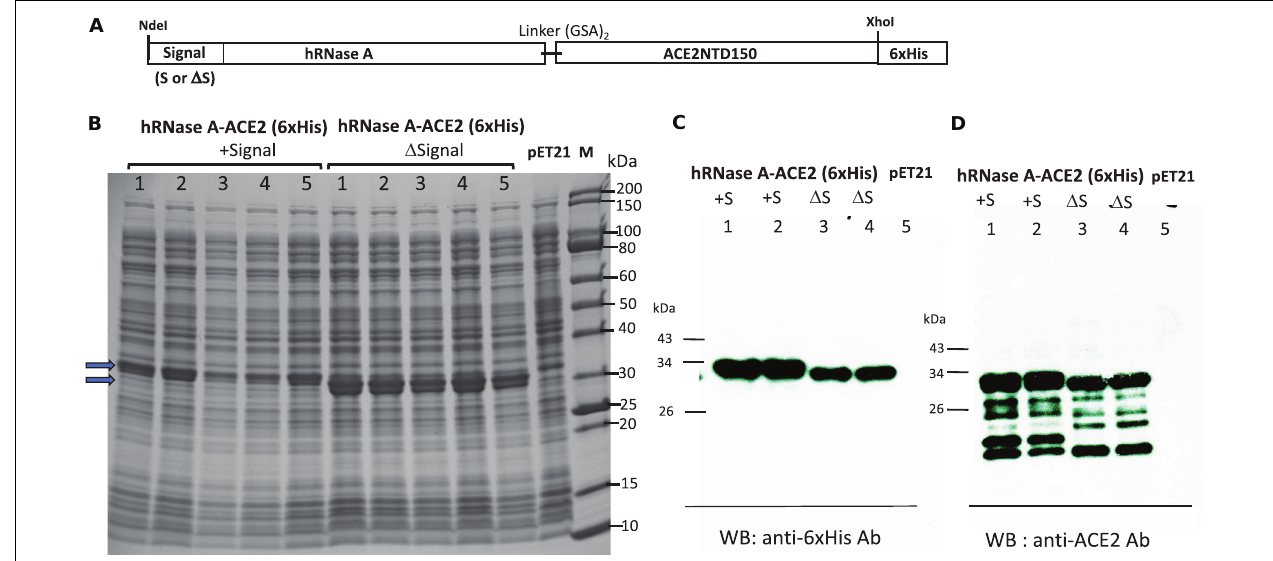
FIGURE 6 | Expression of hRNase A-ACE2NTD150 in T7 Express LysY/ lacI q (C3013). (A) Schematic diagram of the fusion protein. (B) SDS-PAGE analysis of five isolates of hRNase A-ACE2NTD150 (five isolates with MBP signal peptide, five clones without MBP signal peptide). Total cell lysate of pET21b serves as a negative control. (C,D) Western blot analysis of the fusion proteins (soluble fraction/supernatant) by anti-His mAb and anti-ACE2 mAb.